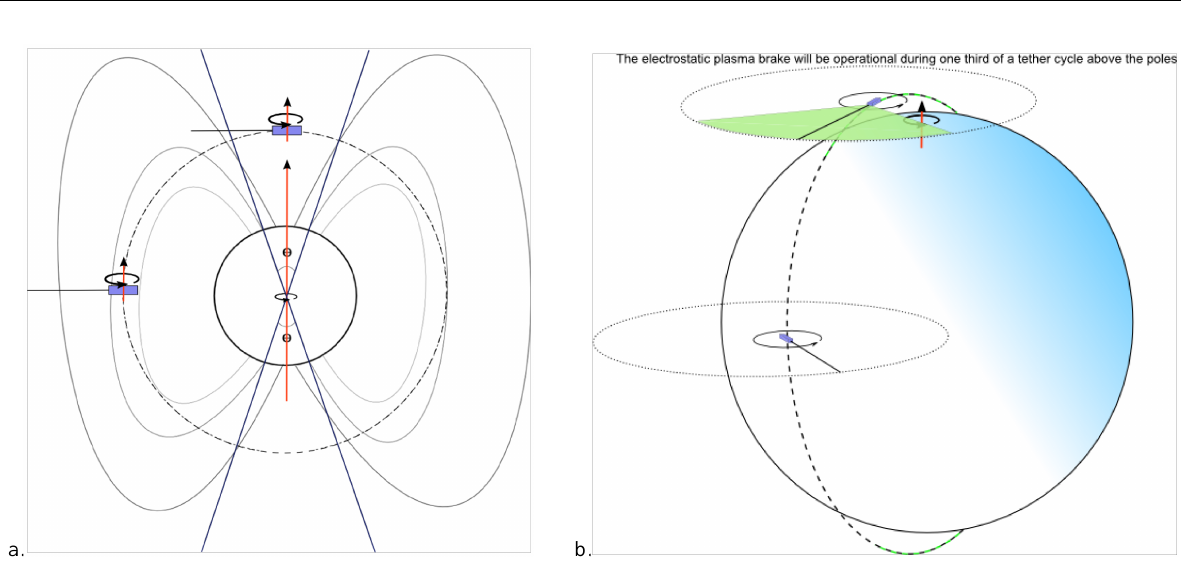
Fig. 8. (a) An example of the satellite moving in the magnetic field of the Earth. (b) Illustrating how the tether is active only in the vicinity of the poles (within an angle of 20 ◦ ), marked as angle 8 in (a)